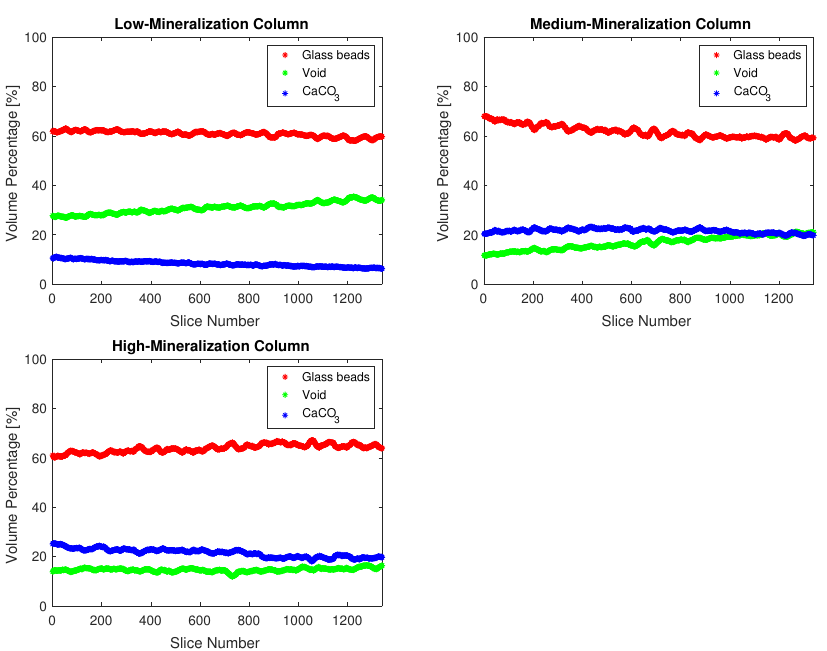
Figure 13. Volumes of the segmented phases (glass, void, and CaCO their distribution along the height of the three sample columns: low ( left ), medium ( right ), and high mineralization ( bottom